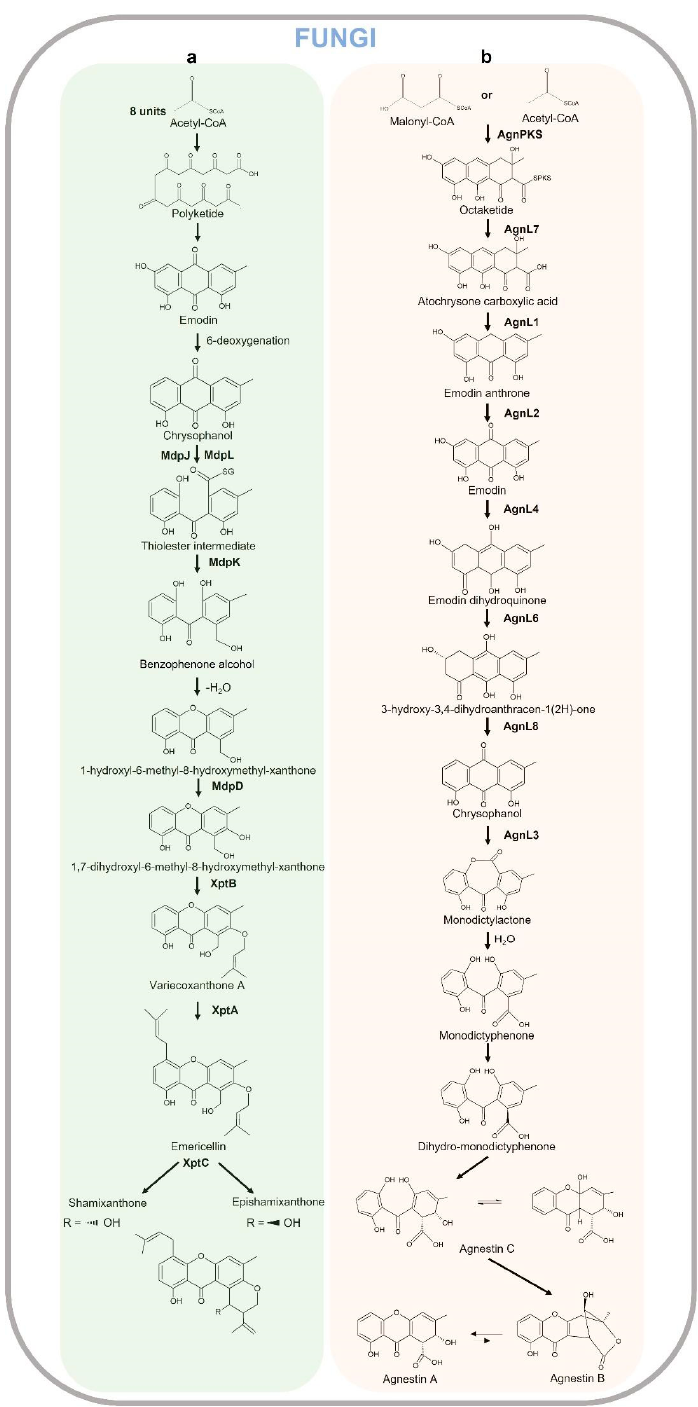
Figure 9. Xanthone biosynthetic pathways in fungi. Shamixanthone ( a ) and agnestin pathway ( b